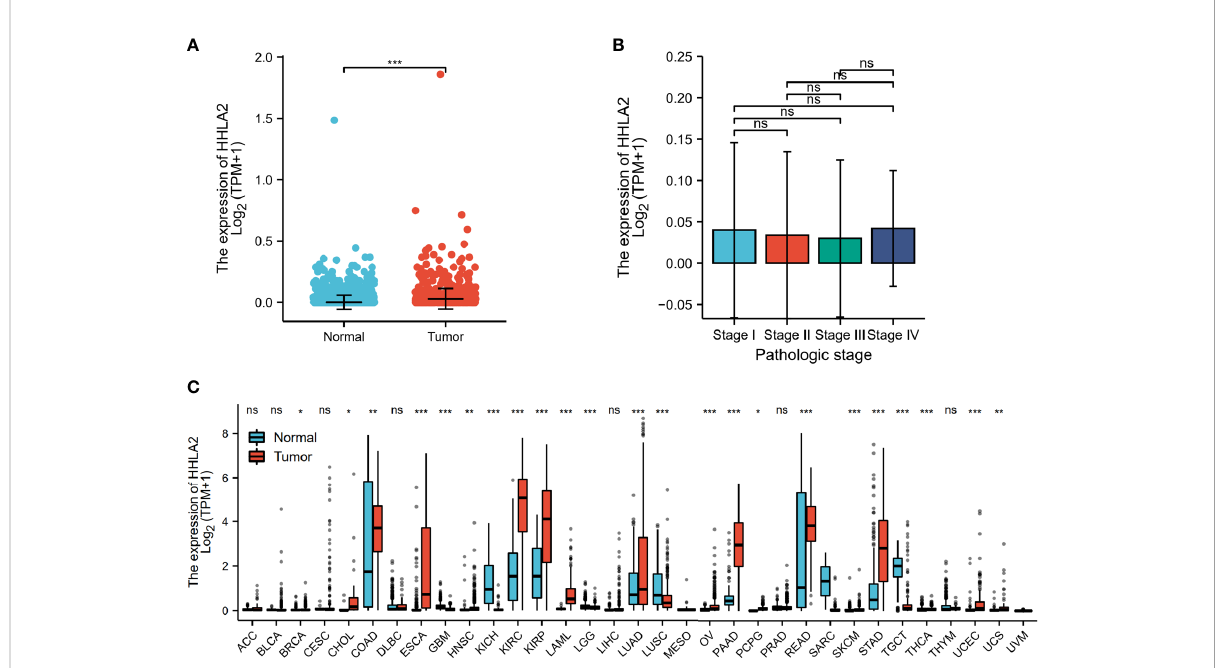
FIGURE 1 Expression levels of HHLA2 in different tumors; (A) Expression level of HHLA2 in SKCM; (B) Expression levels of HHLA2 in SKCM at different TNM stages; (C) Expression levels of HHLA2 in 33 types of cancers. ‘ * ’ stands for P < 0.01, ‘ ** ’ stands for P < 0.001, ‘ *** ’ stands for P < 0.0001. Ns, no signi fi